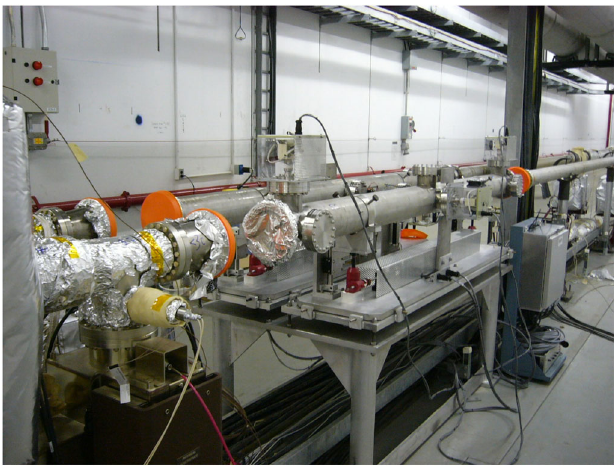
FIG. 4. Location of wires in RHIC and location of long-range beam-beam interaction for compensation.